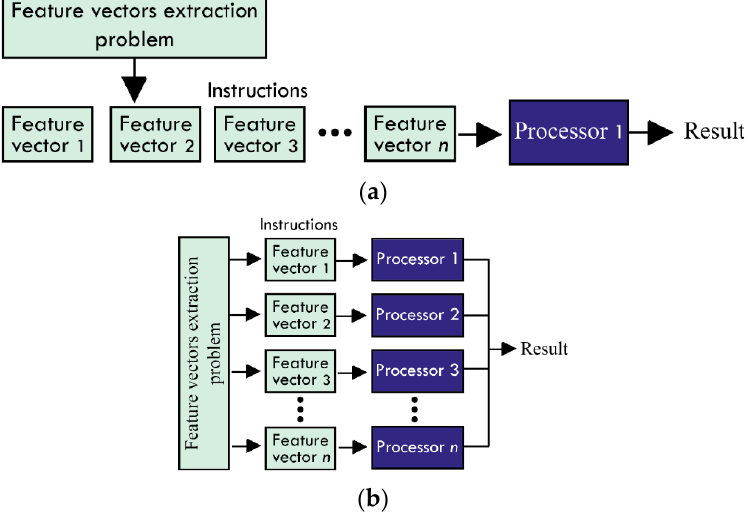
Figure 12. Feature vectors extraction using ( a ) the sequential approach, and ( b ) the parallel one.